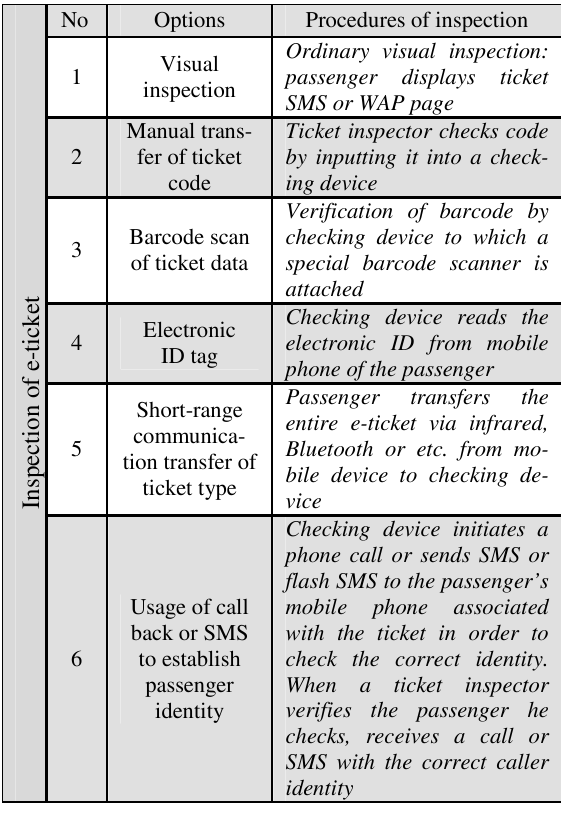
Table 2. Options of inspection of